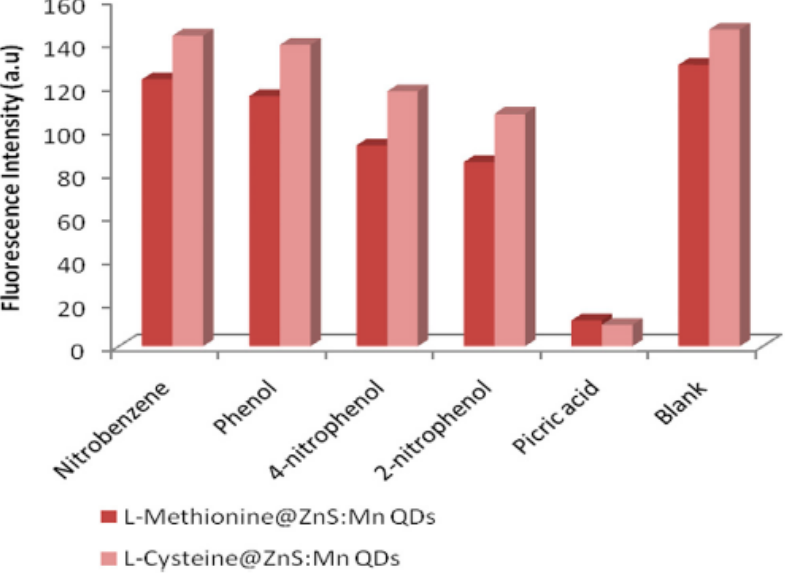
Figure 4. Effect of various aromatic compounds on the fluorescent intensity of L-cysteine/L-methionine-capped ZnS-Mn 2+ QDs (concentration of picric acid is 2 × 10 − 7 M and other aromatics are 2 × 10 − 5 M).